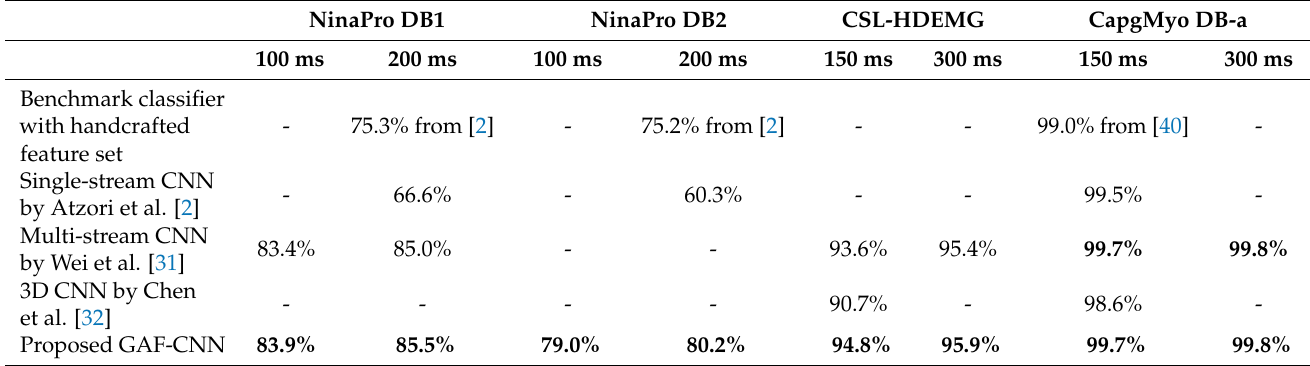
Table 2. Classification accuracies achieved by GAF-CNN when evaluated on publicly available sEMG datasets, along with the state of the art as reported by previous work incorporating CNN models. The first row indicates the in-use datasets, and the second row indicates the experimental conditions for sliding window lengths. The bold font indicates the best result under the same conditions in